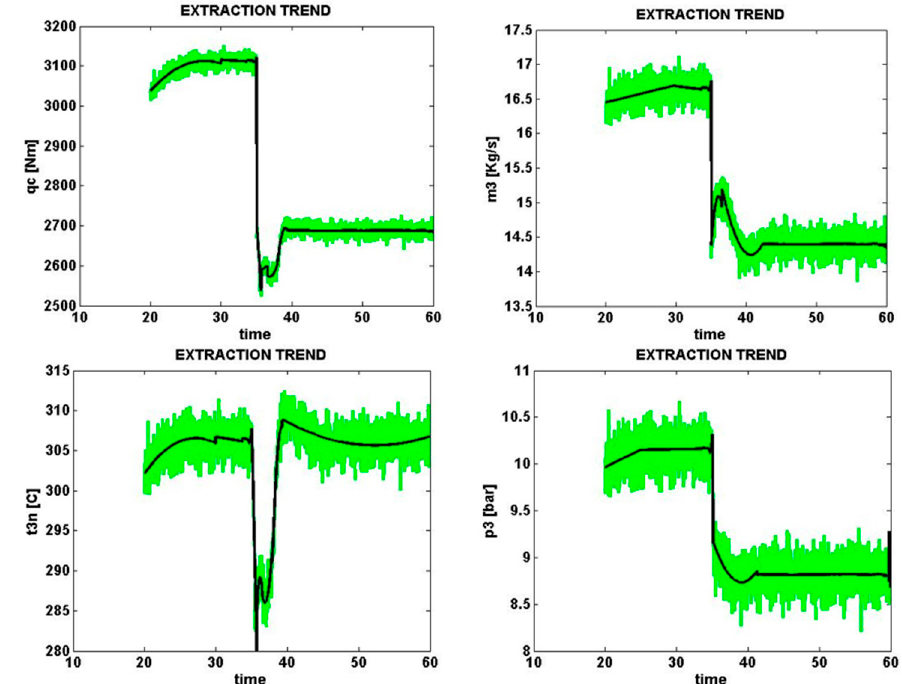
Figure 9. Occurrence of partial shadow to zero error rate (normal).